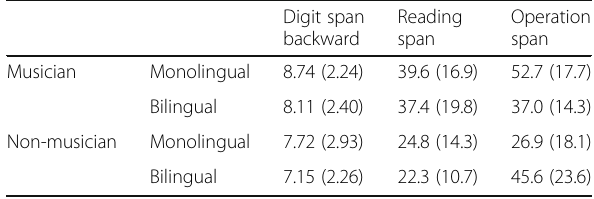
Table 2 Mean correct items (SD) on working memory